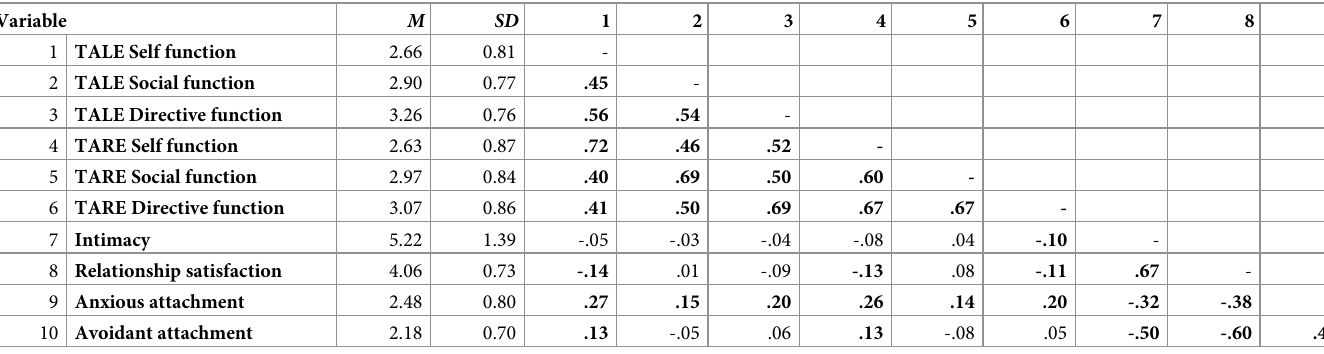
Table 5. Descriptive statistics and correlations among the Study 2 variables.